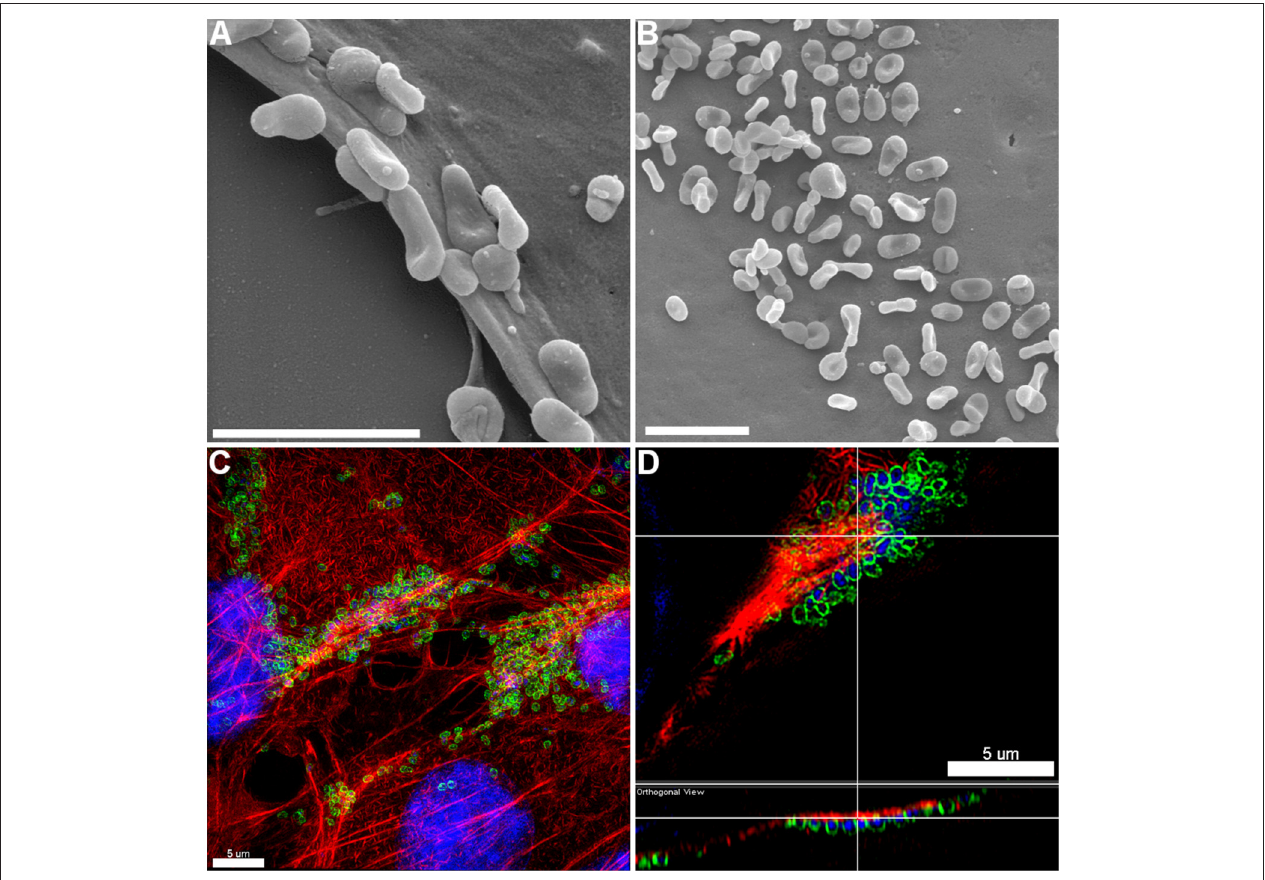
FIGURE 2 | Adherence patterns of M. hyopneumoniae cells to PK-15 monolayers. (A,B) Scanning electron microscopy (SEM) image of M. hyopneumoniae cells adhering to PK-15 monolayers. M. hyopneumoniae cells favor the leading edge of epithelial cells (A) and select pockets on the top of the cells (B) , a pattern consistent with selective localization of epithelial receptors that are a target of adhesins on the surface of M. hyopneumoniae . Scale bars in (A,B) are 2 µ m. (C,D) 3D-SIM images of M. hyopneumoniae adhering to PK-15 cell monolayers. M. hyopneumoniae cells were labeled with F2 P94 − J antisera conjugated to CF TM 488 (green), nucleic acids were stained with DAPI (blue), and F-actin was stained using phalloidin (red). M . hyopneumoniae cells often localize to regions enriched in F-actin. (D) Orthogonal view showing M. hyopneumoniae cells associating closely with F-actin. Upper panel shows xy orientation and bottom panel shows xz orientation. White lines indicate the same area within the